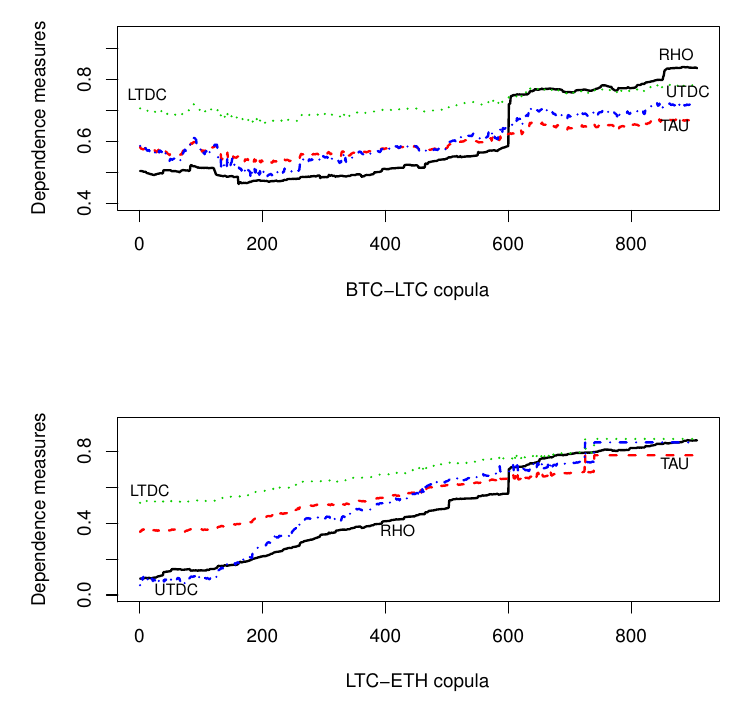
Figure 5. The dynamic estimates of the dependence measures for the (BTC,LTC) and (LTC,ETH)